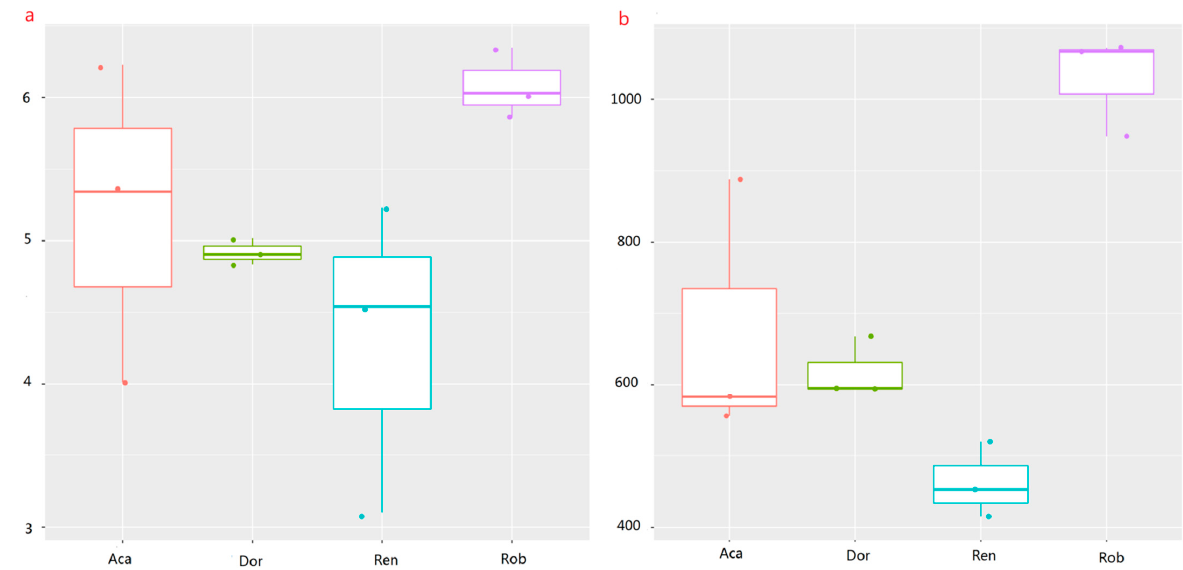
Figure 2. The diversity and richness of orchid root-associated fungal (RAF) communities. The Shannon ( a ) and Chao ( b )